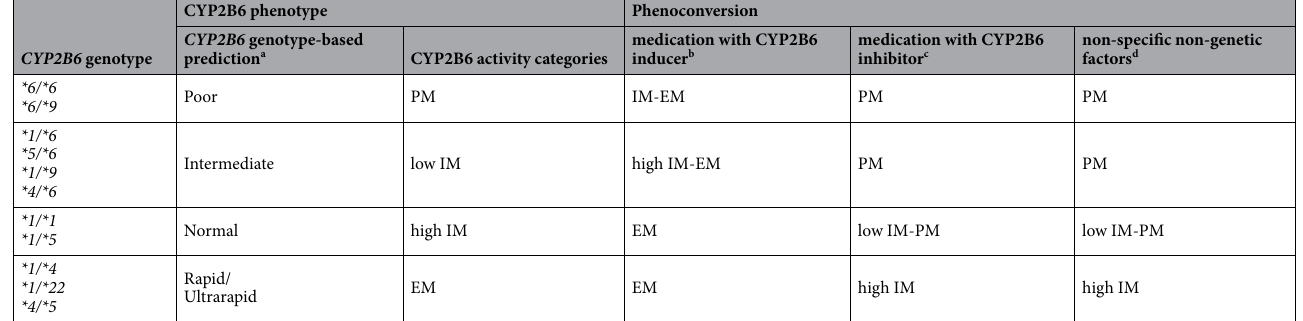
and 99.9 pmol*mg −1 *min −1 for poor, intermediate and extensive metabolizers. Approximately two thirds of the liver tissues (65%) displayed intermediate S -mephenytoin N -demethylase activity, whereas of 105 tissue donors, 18 and 19 showed low and extensive CYP2B6 activities, respectively. Furthermore, significant differences in hepatic CYP2B6 mRNA expression were observed between various CYP2B6 activity groups (N = 84, P < 0.0001) (Fig. 1B). Demographic parameters, such as age (data not shown) or sex (Fig. 2, Table 4), appeared not to influ- ence CYP2B6 activity. No significant differences between men and women were observed in S -mephenytoin N -demethylase activity, and the distribution of men and women in the activity categories or in genotype-based categories were found to be homogenous (Fig. 2A,B).